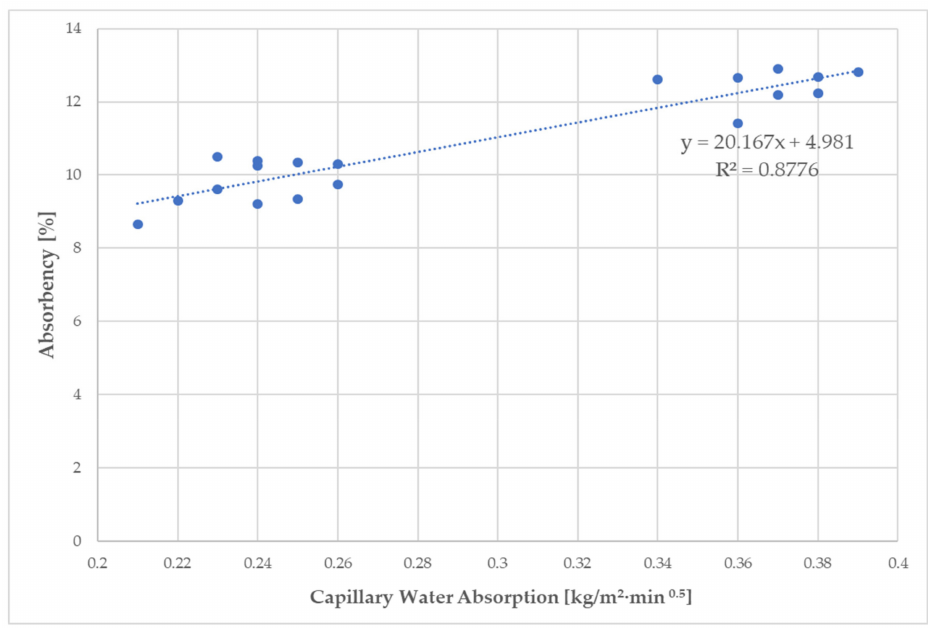
Figure 13. Relationship of the absorbency and capillary water absorption of fiber-cement mortars with increasing fiber content.